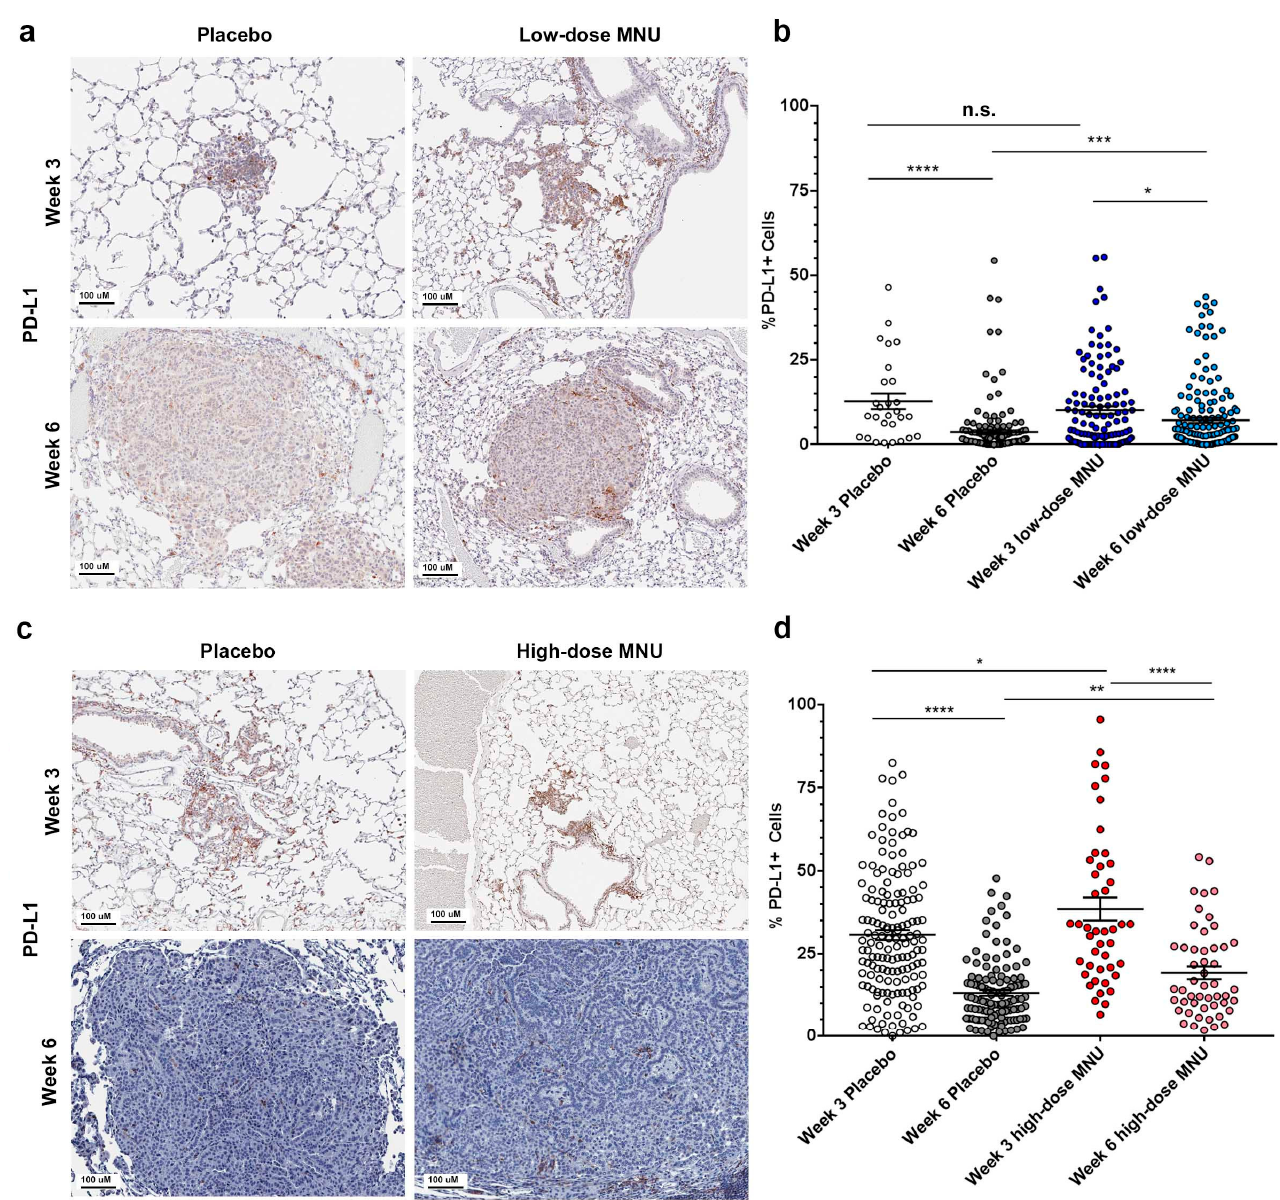
Figure 3. MNU treatment causes sustained immune checkpoint activation in KP tumors. KP mice were treated with low-dose or high-dose MNU for either 3 or 6 weeks, followed by lung extraction and fixation for immunohistochemistry. At both time points, each MNU regimen had a corresponding placebo group. Immune checkpoint activation was evaluated by immunohistochemistry for PD-L1 in tumors. ( a ) Representative pictures of PD-L1 staining KP tumors treated with either placebo or low-dose MNU, as indicated. ( b ) Quantification of the immune checkpoint activation in each tumor of the placebo and low-MNU group at 3 and 6 weeks, as measured by percentage of PD-L1-positive cells in the tumor section. ( c ) Representative pictures of immune checkpoint activation in KP tumors treated with either placebo or high-dose MNU, as indicated. ( d ) Quantification of the immune checkpoint activation in each tumor of the placebo and low-MNU group at 3 and 6 weeks, as measured by percentage of PD-L1-positive cells in the tumor section. The statistical significance of the differences in PD-L1 expression in the MNU groups vs. the respective placebo groups was evaluated by Student’s t -test. * p < 0.05, ** p < 0.01, *** p < 0.001. **** p < 0.0001. n.s. not significant. In the high-dose MNU trial (trial 4), PD-L1 expression was significantly decreased in the placebo mice from week 3 to week 6, from a mean percentage of PD-L1-positive cells of 30.6 ± 1.5% at week 3 to 13.2 ± 0.9% at week 6 (Figure 3c,d). MNU treatment caused a